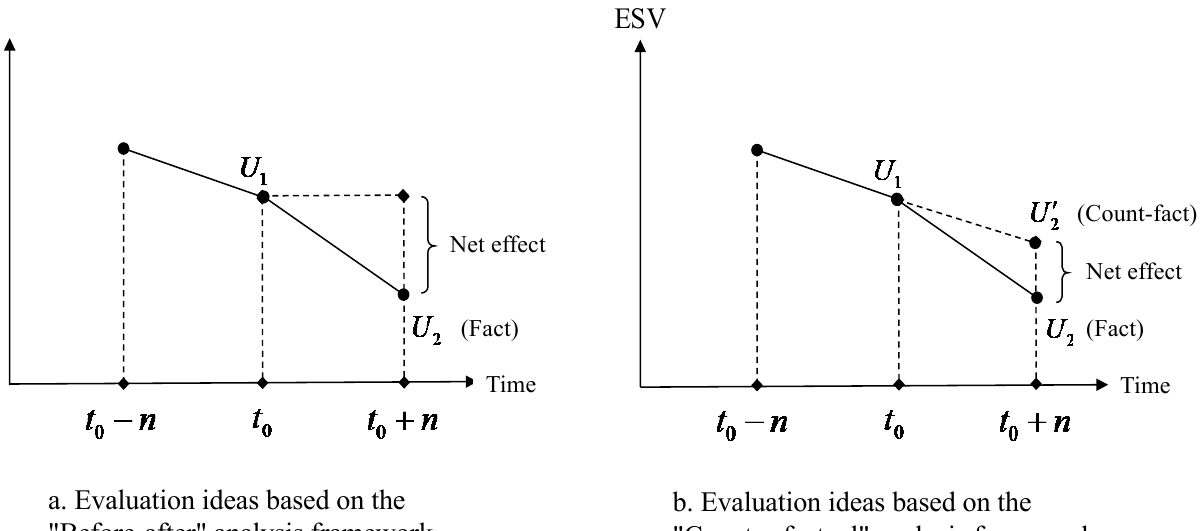
Figure 1. Schematic assessment of the impact of the implementation of the international tourism island construction strategy on the ESV of Hainan Island.